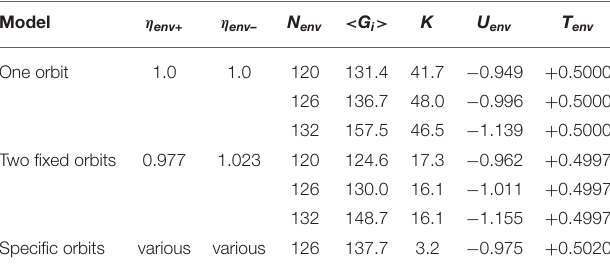
TABLE 2 | Stability and energy of various envelope models.